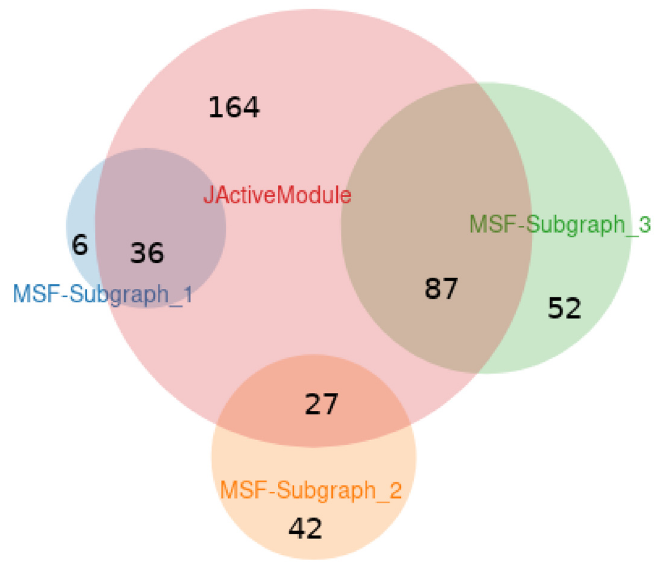
Figure 4. The Venn diagram shows the common genes identified as modulated from MSF identified sub-graphs and jActiveModules identified